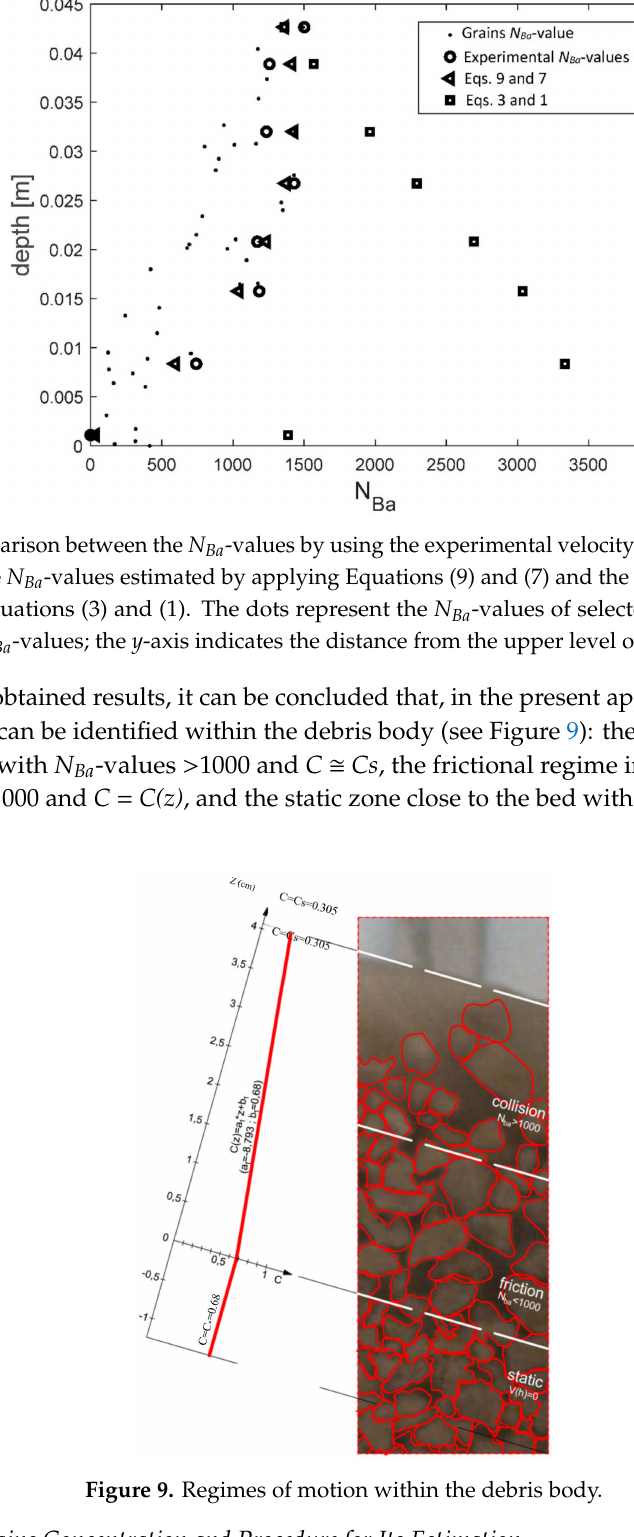
Figure 9. Regimes of motion within the debris